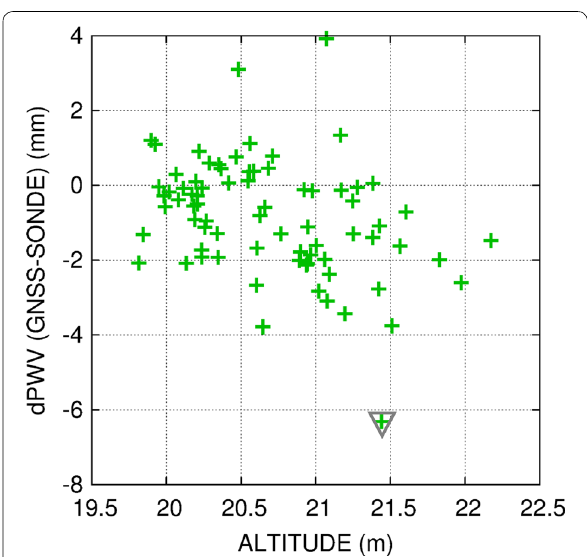
Fig. 9 Scatter plots of the differences in the GNSS PWV versus the radiosonde observations and estimated GNSS antenna (MAST) altitudes. Plots with gray inverted triangles are a comparison with the radiosonde launched at 2331 UTC on June 10, 2017